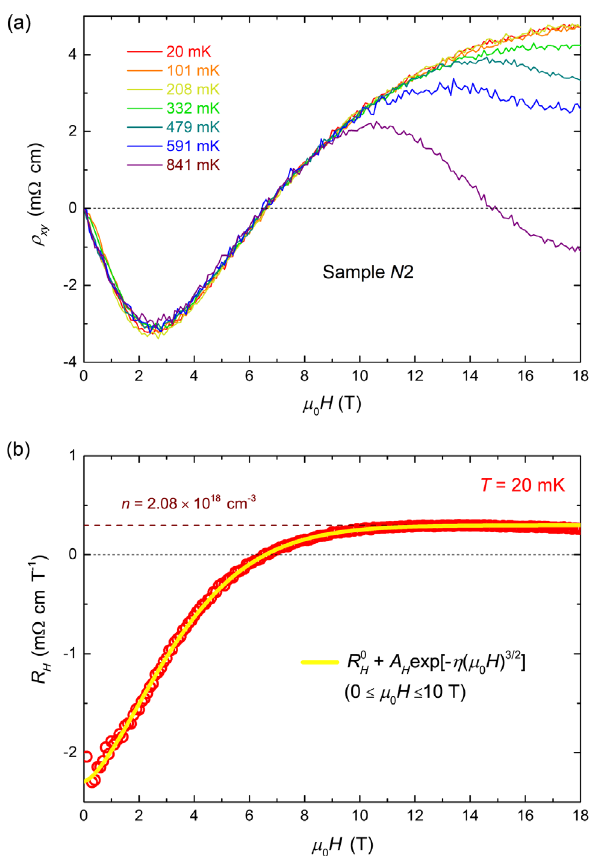
FIG. 1. (a) Hall resistivity ρ of YbB 12 sample N 2 measured in xy a dilution refrigerator in magnetic fields of up to 18 T. ρ shows a sign change at μ 0 H ≃ 6 . 6 T. Below this field, ρ negative and highly nonlinear with magnetic field, showing a low-field Hall anomaly which is nearly T independent from 20 to 841 mK. (b) Fitting of the field dependence of the Hall coefficient R H Þ ≡ ρ H Þ = ð μ 0 H Þ below 10 T using (yellow thick line) the H ð xy ð empirical expression Eq.